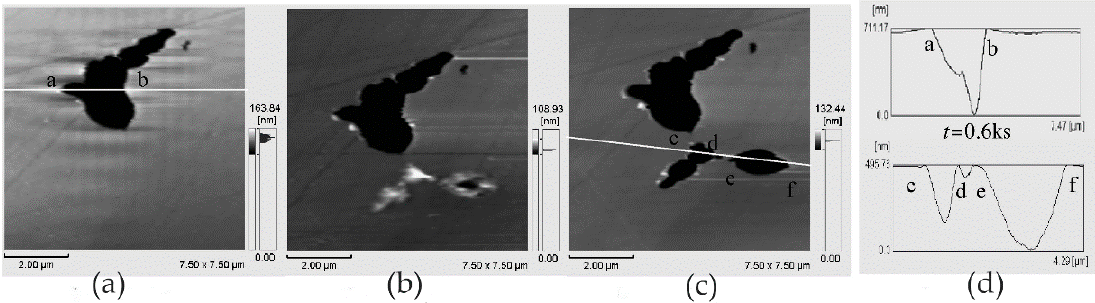
Figure 14. AFM images of sensitization-treated SUS304 stainless steel after corrosion in sodium chloride solution (I = 1 A/m 2 ): ( a ) t = 0.6 ks; ( b ) t = 0.9 ks; ( c ) t = 1.2 ks. ( d ) Cross-sectional profiles of pits along a–b and c–f lines. Reprinted with permission from Reference [48]; copyright 2005 Elsevier Ltd.